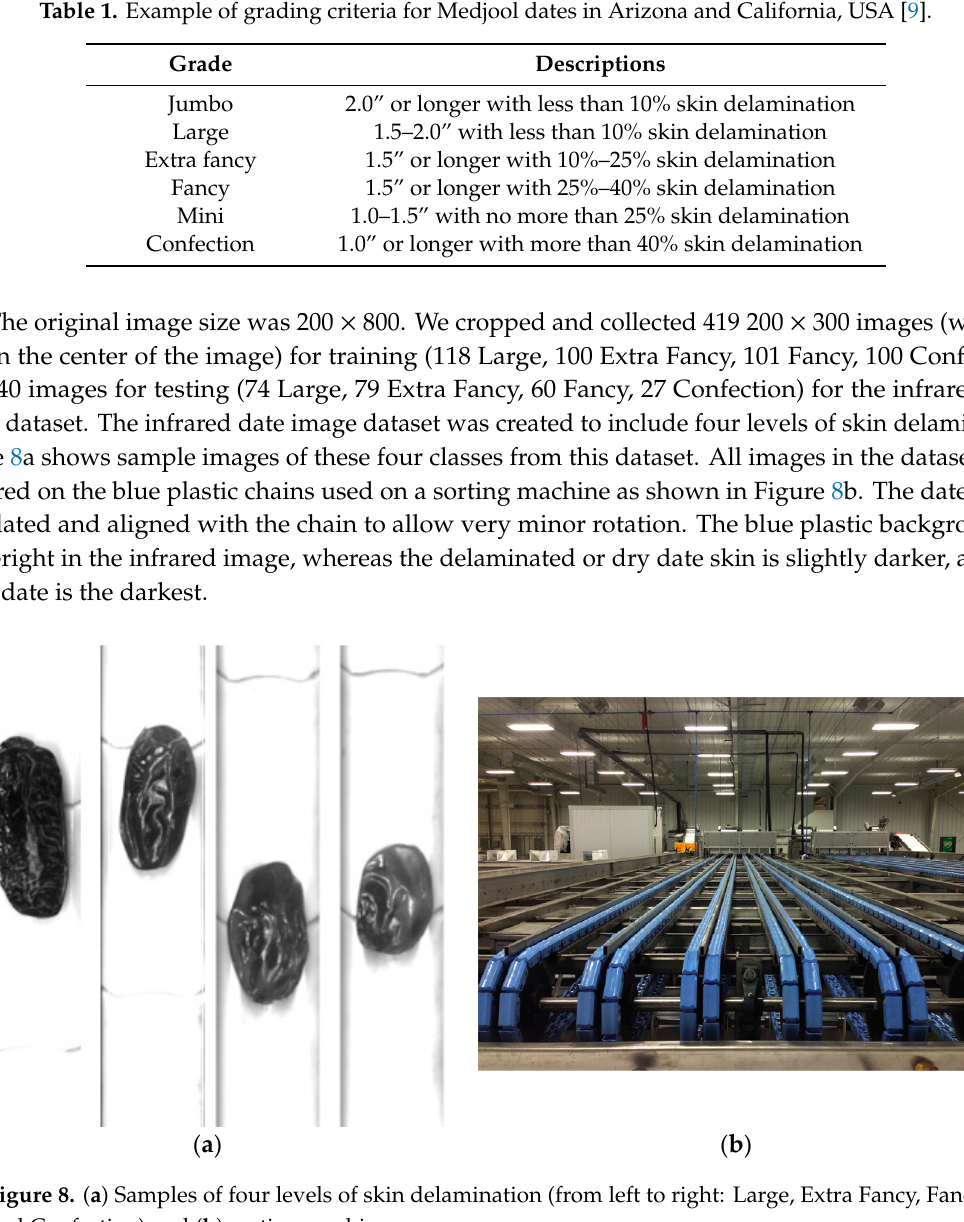
Table 1. Example of grading criteria for Medjool dates in Arizona and California, USA [9].